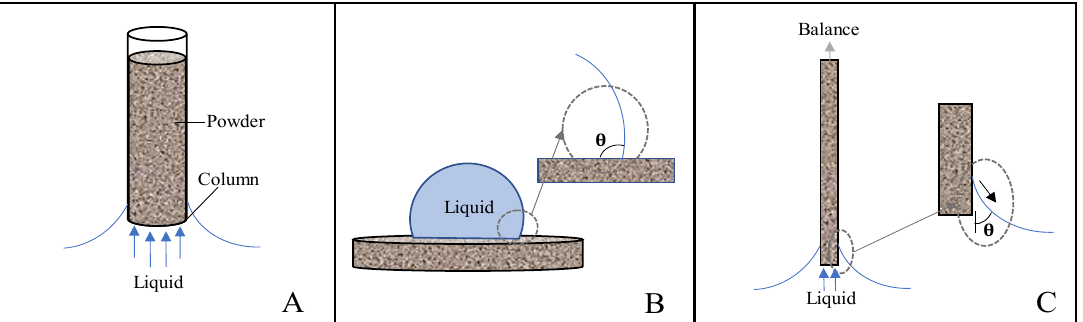
Figure 1. Common methods for wettability determination using contact angles. ( A ) Washburn capillary rise, where a capillary tube is packed with a solid and the liquid taken up is related to the wettability of the powder. ( B ) Static contact angle, where a liquid droplet is placed on a solid and the contact angle is determined from the liquid’s point of contact. ( C ) Wilhelmy plate, where a plate is inserted into a liquid and removed, the surface tension force is balanced by the force needed to pull or push the solid into or out of the liquid.